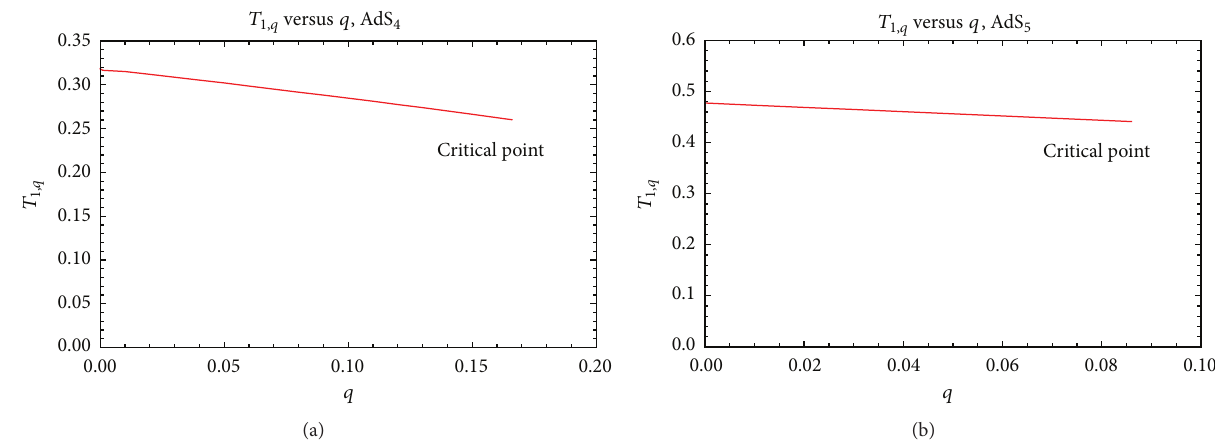
Figure 4: The phase transition temperature 𝑇 1,𝑞 between the pBH1 (branch 1) and pBH3 (branch 3) for fixed 𝑄 ensemble (dual to the fixed density